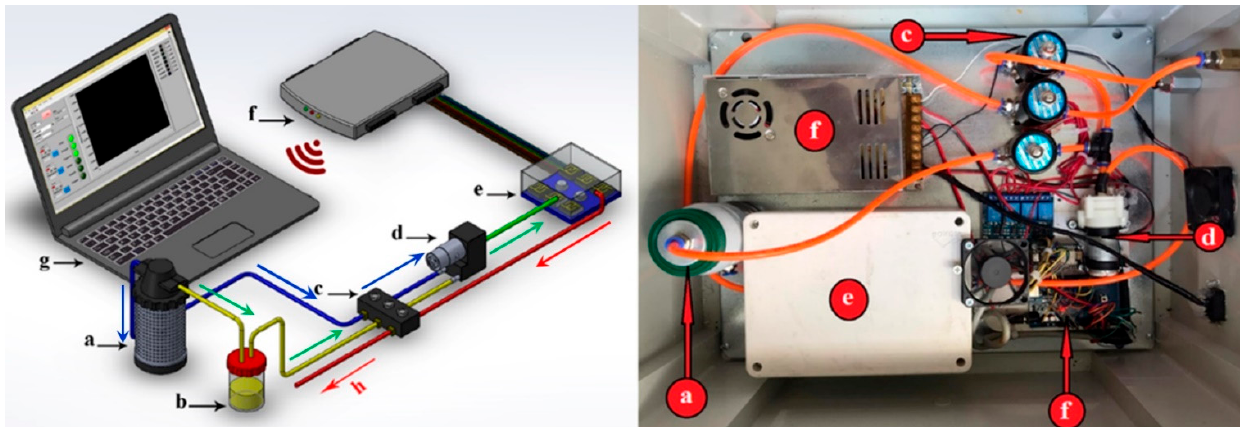
Figure 1. Schematic of an artificial olfactory (e-nose) system, arranged in tandem, for introduction of essential oil VOCs, used for gas-sample analysis. The components of this system consist of the following parts (listed in order and direction of air flow as follows). Ambient air first enters (a) Air filter (activated charcoal to remove ambient-air VOC hydrocarbons), then yellow line to (b) Sample headspace chamber, and (c) Solenoid air valves, then (d) Diaphragm pump, (green line) to (e) E-nose sensor array chamber, (f) Data acquisition recorder and wireless transmission card, (g) Personal computer (PC) and (h), Air outlet (red line) from sensor array chamber (for exhaust gases). Filtered air from Air filter (blue line) alternatively passes to the E-nose sensor array chamber (via Solenoid air valve) during air-cleanse purges between samples.